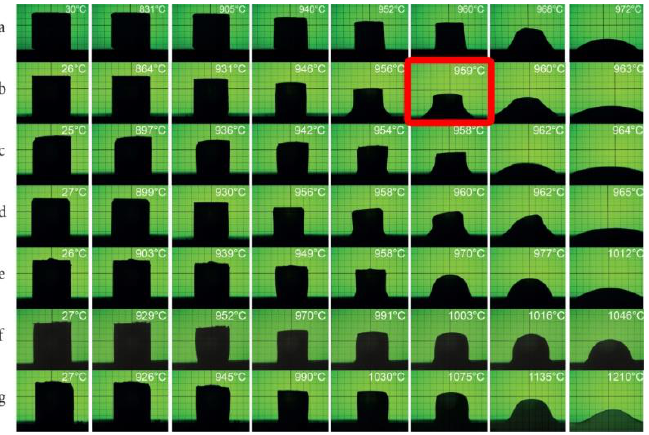
Figure 3. Selected images from a heating microscope for Zn 4 B 6 O 13 –Zn 2 SiO 4 composites: ( a ) 10% Zn 2 SiO 4 , ( b ) 13% Zn 2 SiO 4 (in the red frame—melting point of the eutectic), ( c ) 15% Zn 2 SiO 4 ( d ) 20% Zn 2 SiO 4 , ( e ) 40% Zn 2 SiO 4 , (f) 50% Zn 2 SiO 4 , (g) 60% Zn 2 SiO 4 .